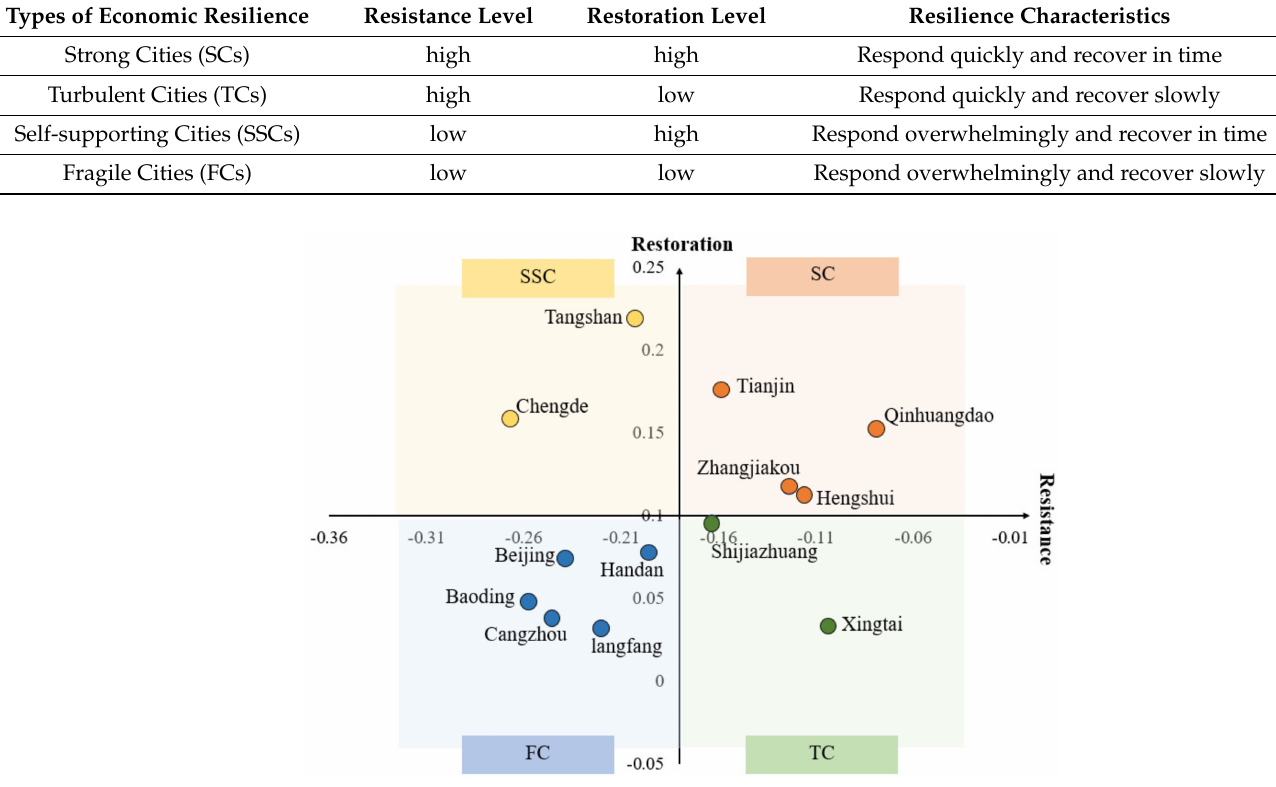
Figure 8. The distribution of economic resilience of the Beijing–Tianjin–Hebei urban